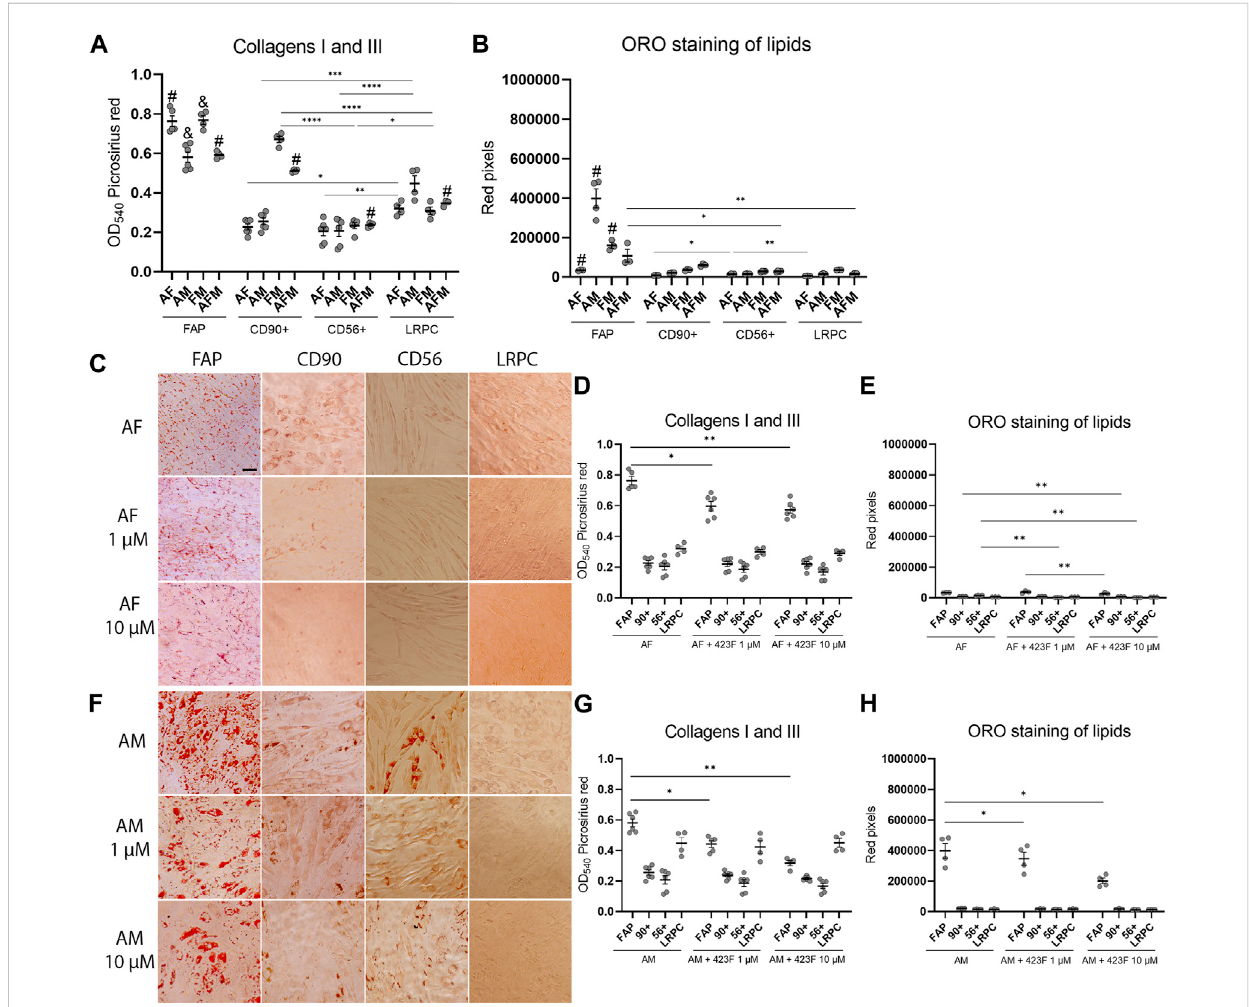
FIGURE 5 423F elicits greater inhibition of human muscle FAP fi bro-adipogenic differentiation than that of CD56, CD90, and LRPC in adipo- fi brogenic and adipo-myogenic cultures. Picrosirius red spectrophotometric quanti fi cation of collagen production (A, D, G) and red pixel quanti fi cation of Oil red O-stained adipocytes (B, E, H) at the indicated conditions (AF = adipo- fi brogenic, AM = adipo-myogenic, FM = fi bro-myogenic, AFM = adipo- fi bro- myogenic)inthepresenceorabsenceof1and10 µM423F.Data(mean±SEM)waspooledfrommultipleexperimentswithtriplicatesforallcultures (n = at least 3 per cell subset). Representative images of Oil Red O-stained adipogenic cells in adipo- fi brogenic (C) and adipo-myogenic (F) cultures for each cell subset. Data was analyzed via paired one-way ANOVA for comparisons between the same cell subset and unpaired one-way ANOVA for comparisons between different cell subsets, followed by Tukey ’ s post hoc multiple comparisons. # denotes signi fi cance between FAP and all other cell subsetsintheAFcondition,aswellassigni fi cancebetweencomparisonsofallcellsubsetsintheAFMcondition.&denotessigni fi cancebetweenFAPand all other subsets in AM and FM conditions. # p < 0.0001, & p < 0.05, **** p < 0.0001, *** p < 0.001, ** p < 0.01, * p < 0.05. Scale bar represents 100 μ